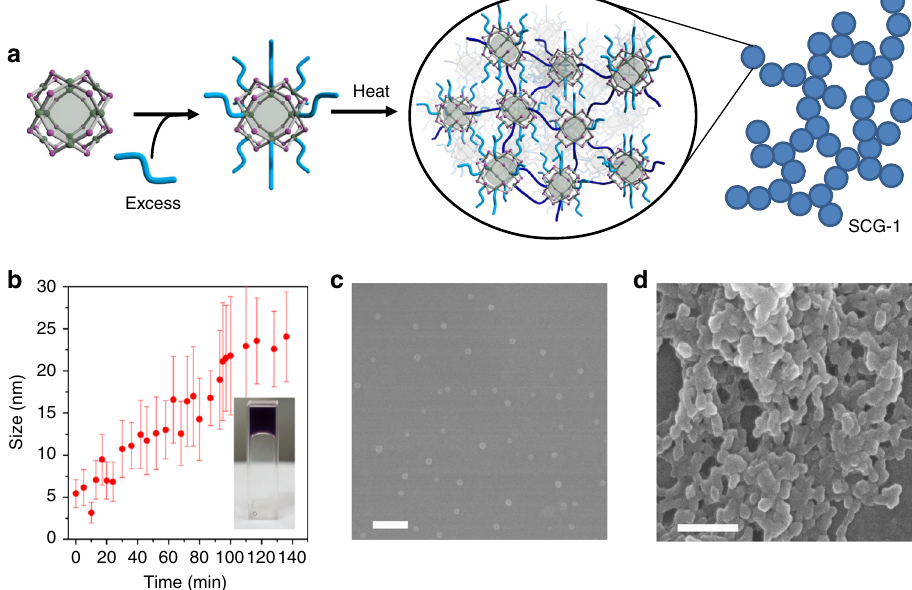
Fig. 4 Polymerization of the kinetically trapped MOP (C 12 RhMOP)(bix) 12 leading to the formation of a supramolecular colloidal gel. a Schematic representation of the proposed mechanism for the formation of SCG-1. b Size evolution of the kinetically trapped C 12 RhMOP(bix) 12 (1.83 mM) molecules when heated at 80 °C, as followed with DLS measurements. (inset) A photo of SCG-1, as formed in the DLS cuvette during the experiment. c Isolated spherical particles obtained by quenching the SCG-1 formation reaction at 95 min. d Fused nanoparticles obtained by quenching the formation of SCG-1 upon reaching the plateau after 136 min. Scale bars: 200